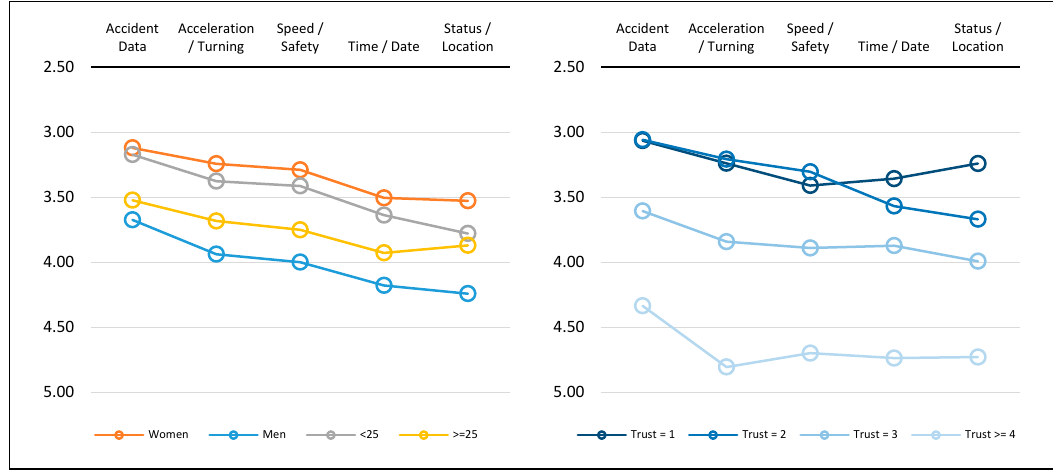
Figure 4. Willingness to share by gender/age group and by level of trust in insurance.